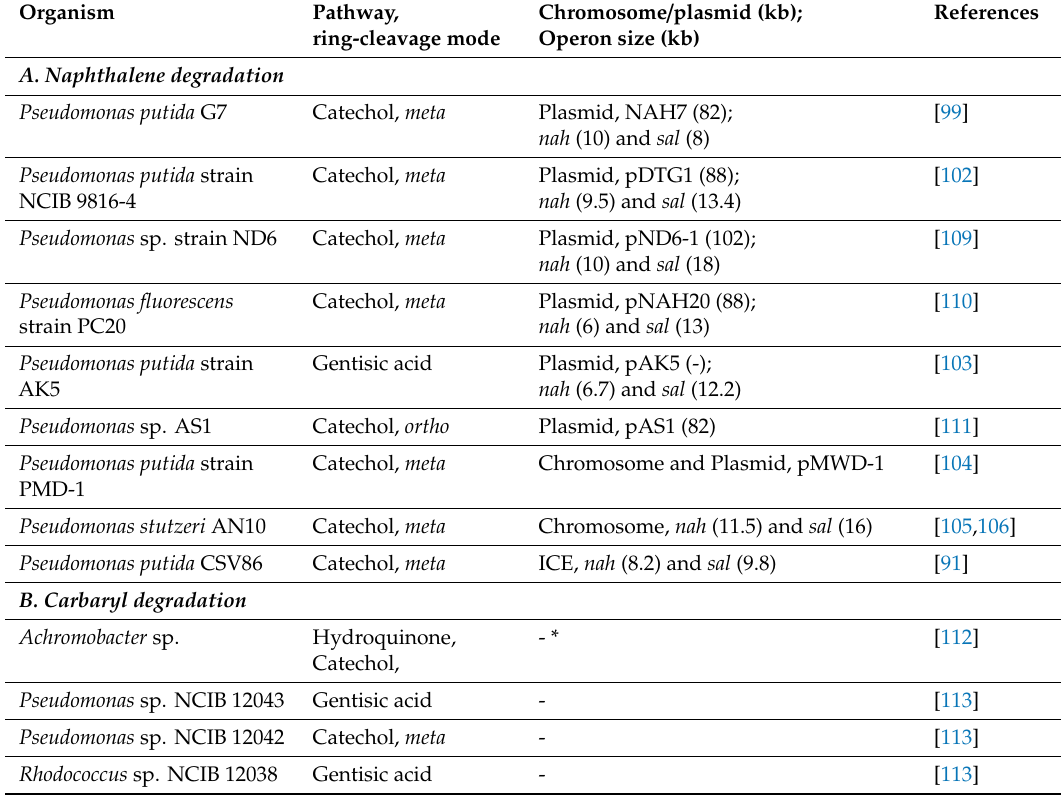
Table 1. Naphthalene and Carbaryl degradation pathways and location of genes from various isolates. Organism Pathway, Chromosome / plasmid (kb); ring-cleavage mode Operon size